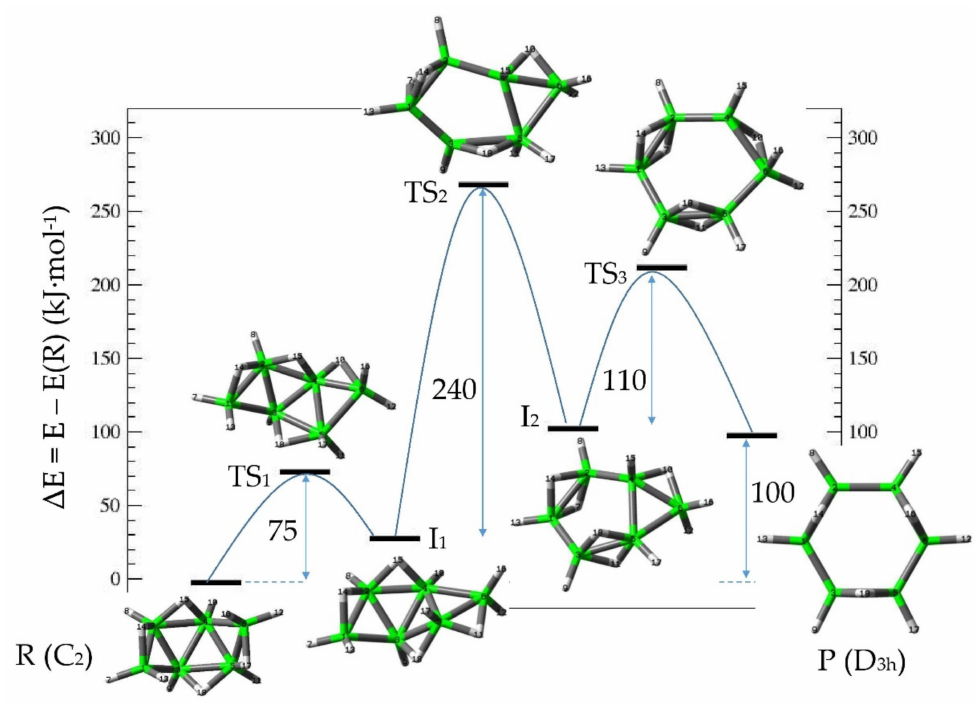
Figure 2. Reaction pathway along the IRC from reactant (R) 3D C 2 hexaborane(12) to product (P) 2D D 3h